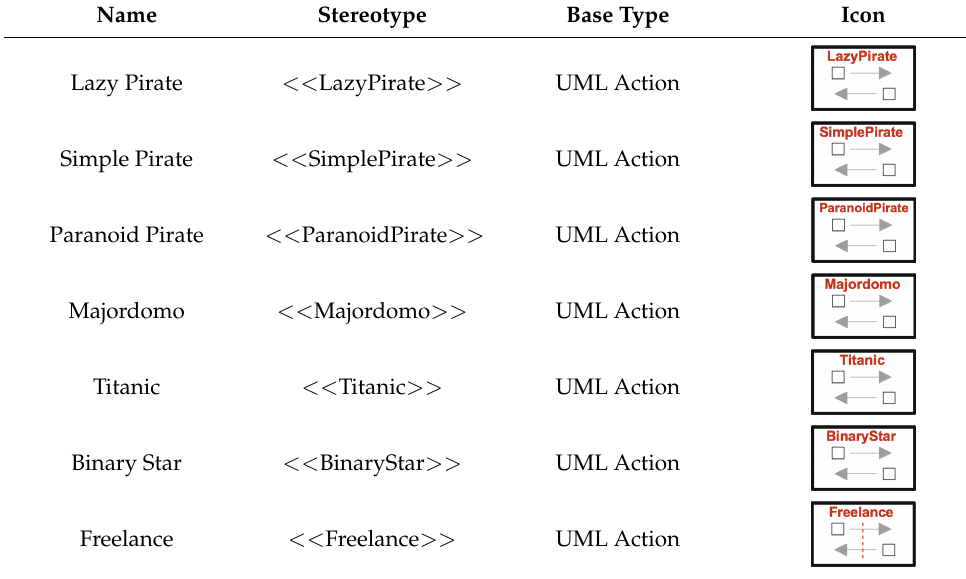
Table 6. Selected stereotypes for ZeroMQ specializations of the Request–Reply pattern.